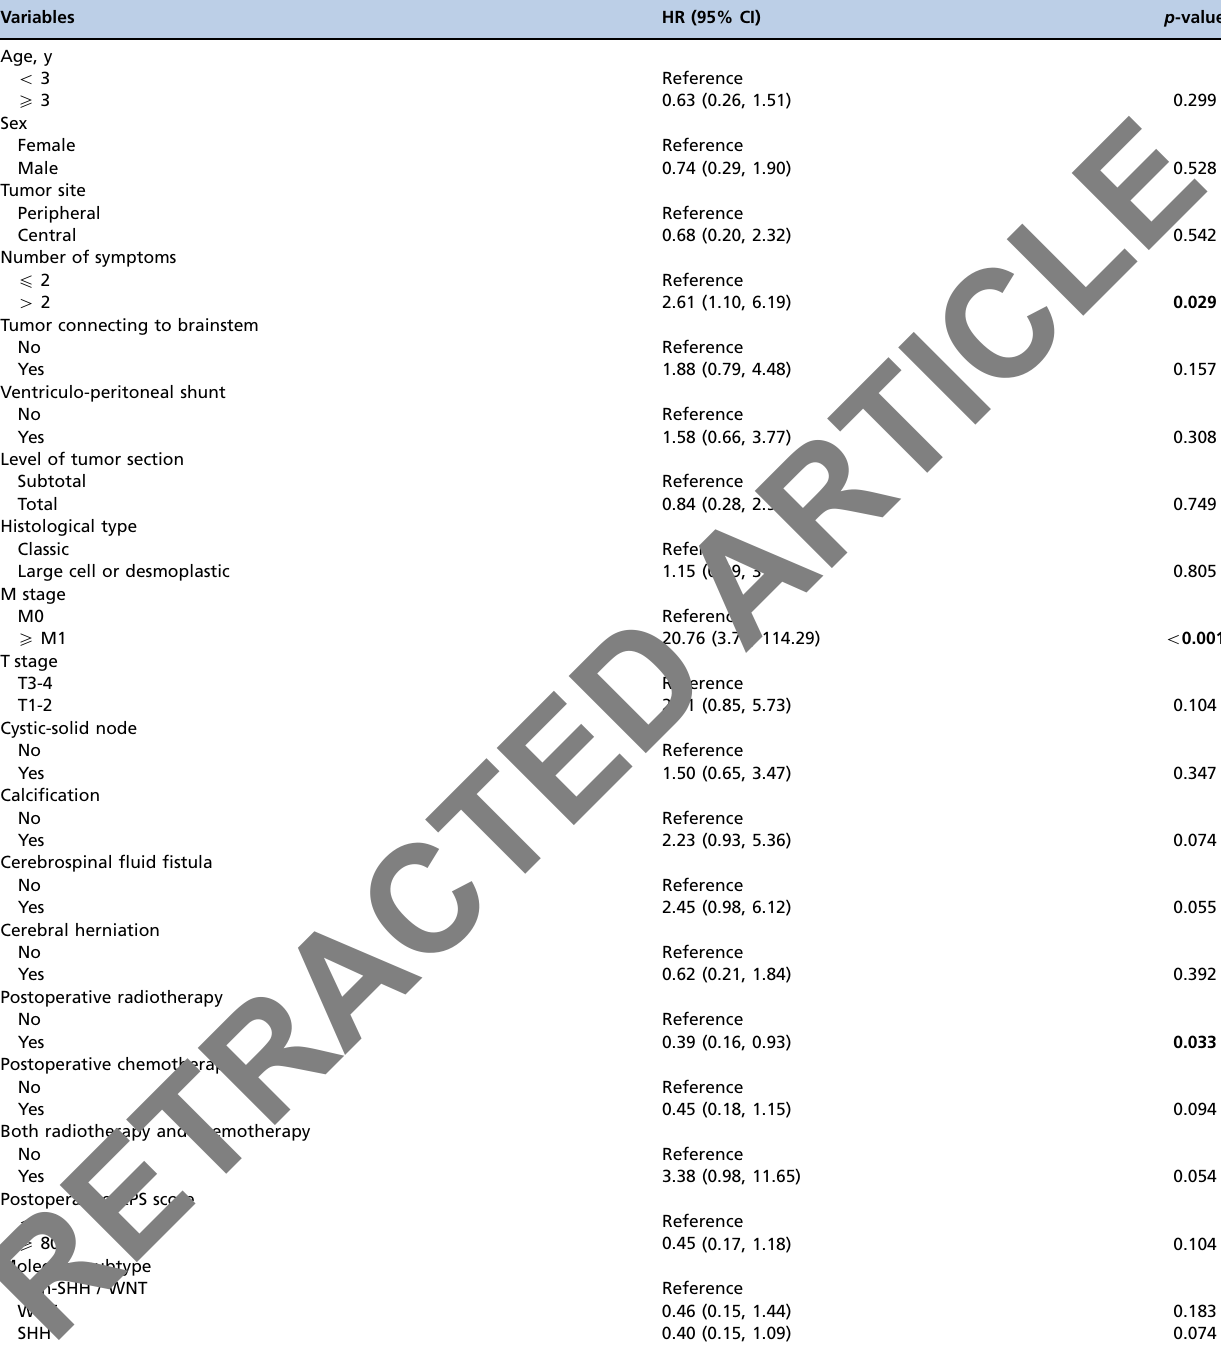
Table 3 - Univariate Cox proportional hazard model of factors associated with disease progression.